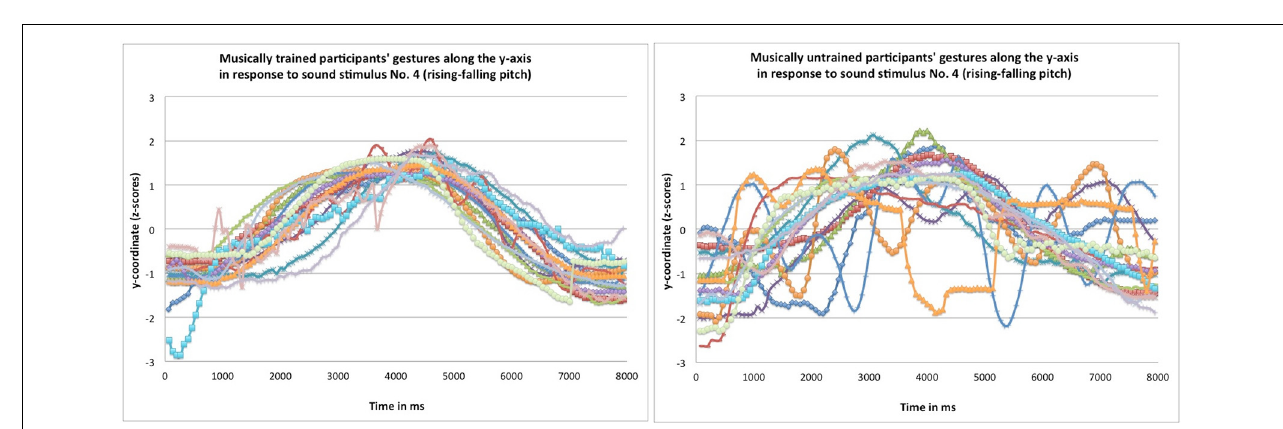
FIGURE 2 | Gestural trajectories along the y-axis in response to sound stimulus rising and falling in pitch (No. 4) by a subsample of 16 randomly chosen musically trained participants (left) and 16 randomly chosen musically untrained participants (right).